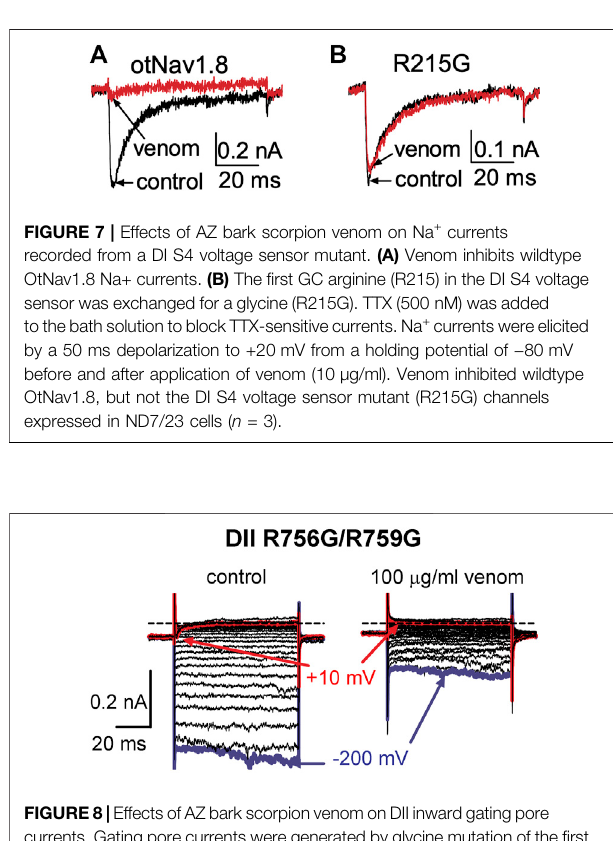
FIGURE 6 | Effectsof AZ bark scorpion venom on DI inward gating pore currents. Gating pore currents were generated by glycine mutation of the fi rst and second gating charges (two outermost arginine residues) on OtNa V 1.8 DI S4 (R215G/R218G). (A – C) Schematic diagram depicting channel central pore current (A) , generation of inward gating-pore current (B) , and block of inward gating pore current by venom (C) . (D) A typical protocol was usedtoelicitinwardgatingporecurrent.Cellsheldat − 80 mVwerestimulated by50-mshyperpolarizingstepstovariouspotentialsthatranged from – 200to +40 mV in 10-mV increments. (E) 100 μ g/ml venom completely inhibited central pore current of wild type OtNa V 1.8 channels but failed to affect background leak currents. (F) 100 μ g/ml venom only partially inhibited central pore currents recorded from OtNa V 1.8 mutant channels, suggesting that the double mutation (R215G/R218G) on DI S4 could reduce venom binding af fi nity towards OtNa V 1.8 channels. Venom also depressed inward gating pore currents through the DI voltage sensor domain (VSD). Blue and red traces represent typical leak current (gating pore current) and central pore current at − 200 and − 10 mV, respectively.